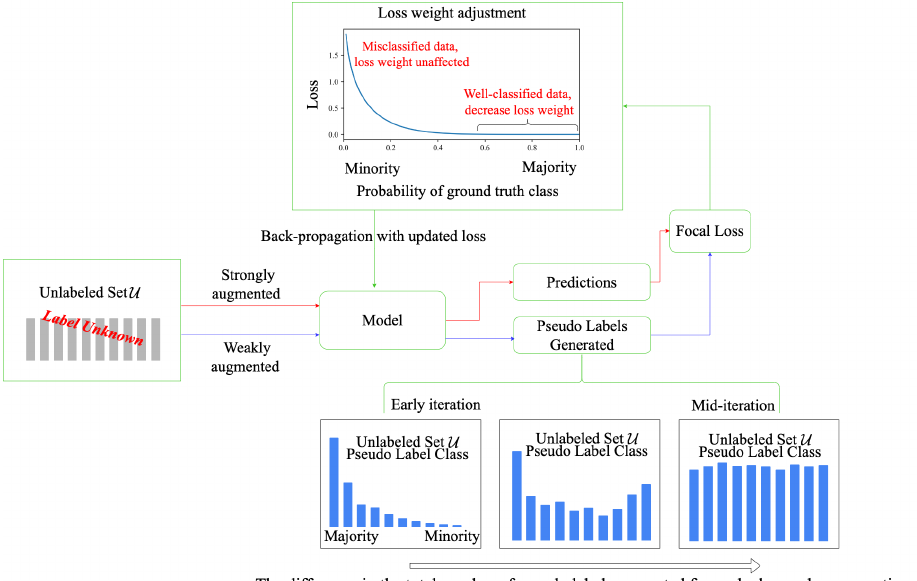
Figure 1. Framework of FocalMatch. Unlabeled data is fed into the model, and the model generates pseudo labels based on the weakly-augmented unlabeled data. At early iterations, the model prefers certain classes for pseudo labels, which causes severe class imbalance. Then, the model makes predictions on the same unlabeled data but with strong augmentation. The model calculates the loss between predictions and pseudo labels via focal loss [17] to ensure consistency. Focal loss adjusts the weight of different data based on how close their predictions are to their pseudo labels. For well- classified data (i.e., the majority of pseudo labels), their loss contribution is reduced. Therefore, the model can rapidly eliminate class imbalance at early